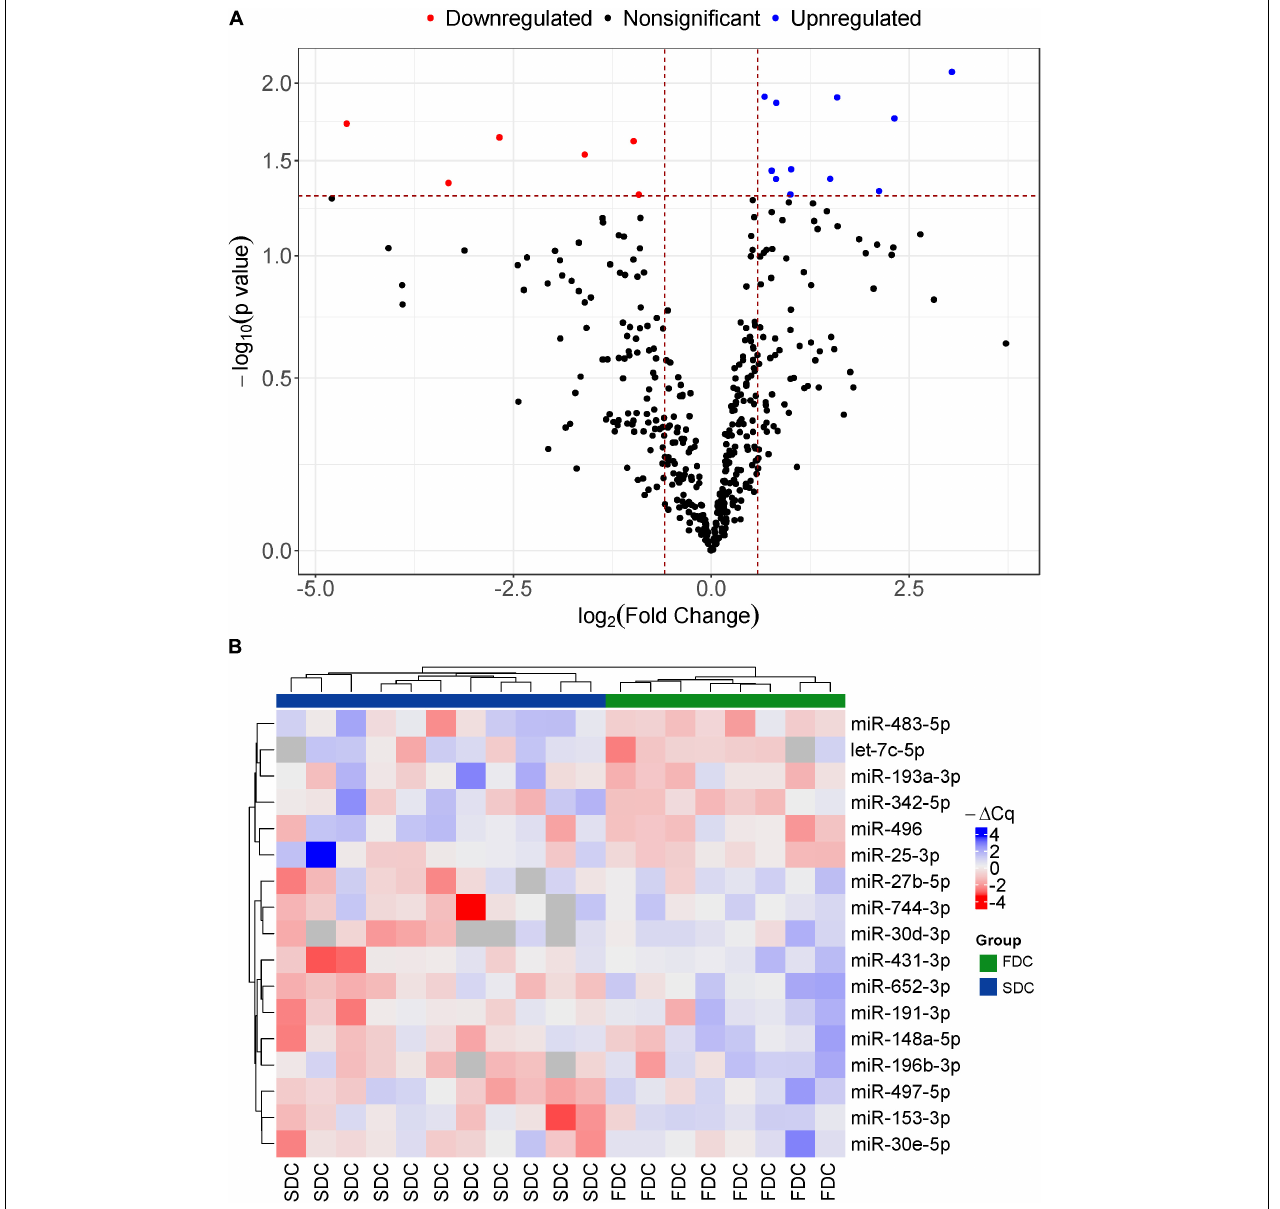
FIGURE 1 | (A) Volcano plot of the distribution of 17 differentially expressed miRNAs at baseline between patients with FDC and SDC in the discovery study, mapping six downregulated miRNAs (red dots) and 11 upregulated miRNAs (Blue dots) in the FDC group; (B) Heatmap of all differentially expressed miRNAs at baseline between AD patients with FDC or SDC in the discovery cohort. Red is low expression and blue is high